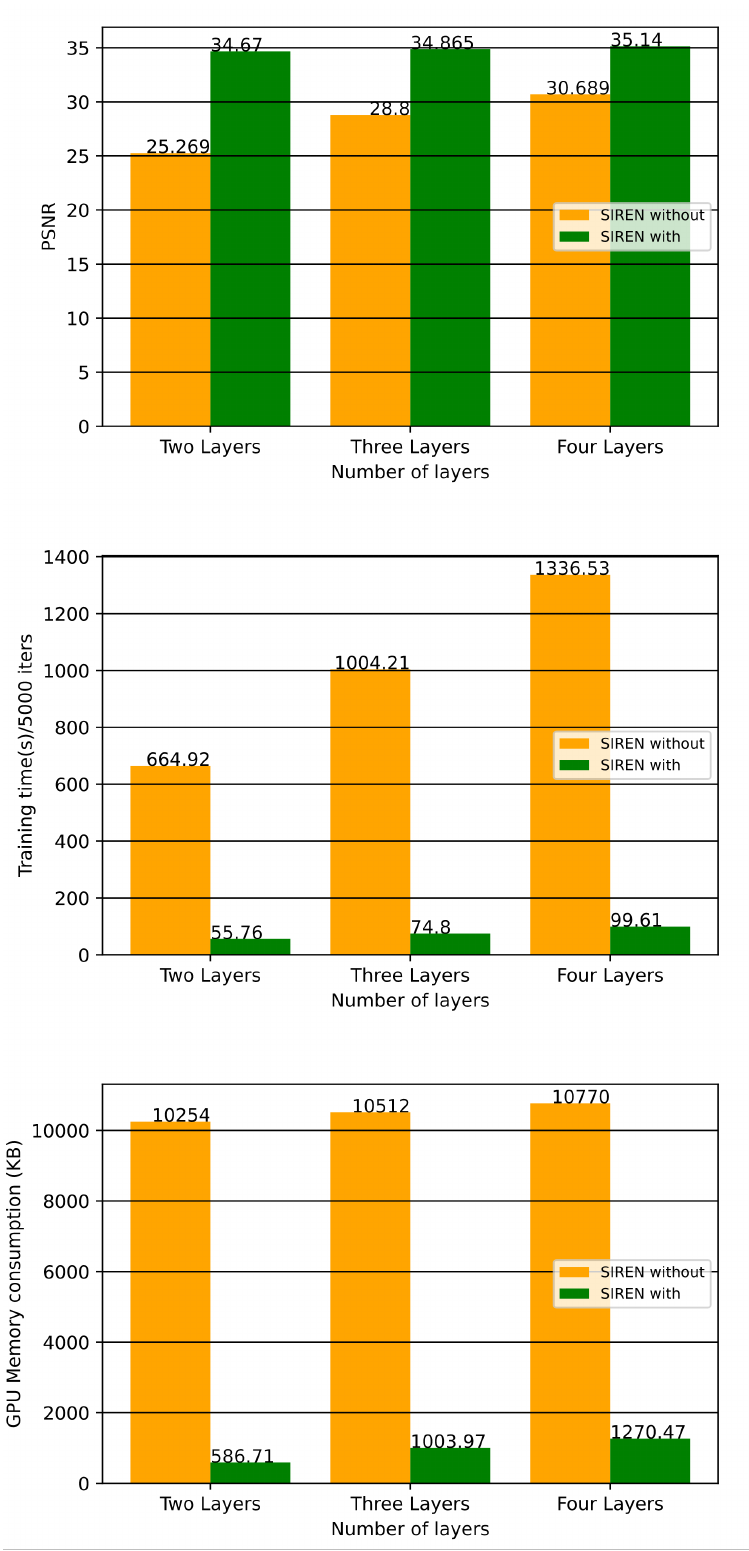
Figure 13. Bar charts compare the results of using SIREN without our architecture [2] and with our architecture. As can be seen, SIREN implementation with our architecture outperforms using SIREN without our architecture [2] in terms of quality, speed, and GPU memory allocation with 2, 3, and 4 MLP